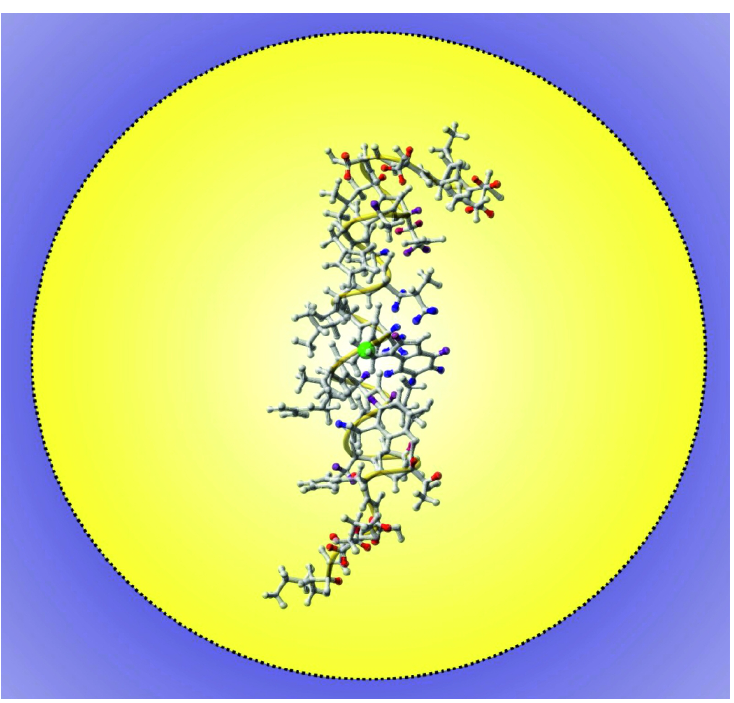
Figure 2. Localization and orientation of the transmembrane helix 7 (TM7) of yeast V-ATPase in DPC micelles as obtained by PREs induced by Gd(DTPA-BMA). The PREs are indicated by the color code on the hydrogen atoms for which they were determined with red indicating high PREs and therefore close proximity to the surface and blue is used for low PREs and localization deep in the